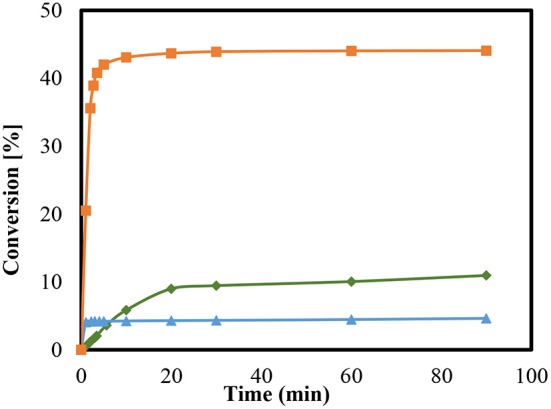
Conversions of condensation reaction between glycerol and acetone at room temperature using modified and unmodified MCM-41; MCM-41pure (), MCM 41- TD (), and MCM 41- SU ().